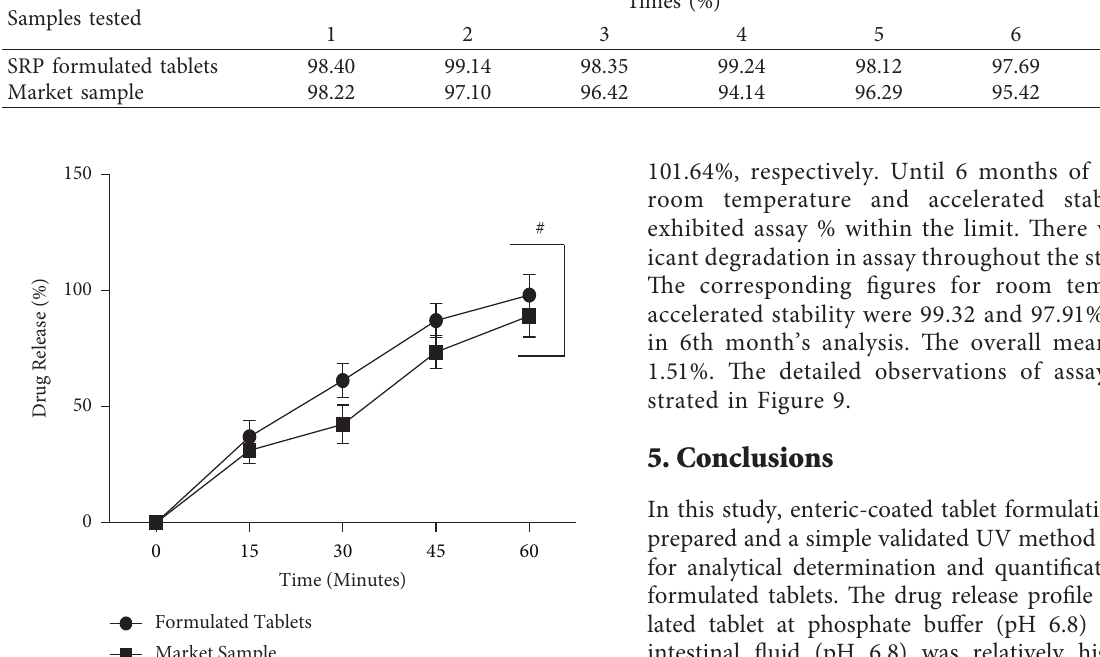
Figure 8: SRP release in simulated intestinal fluid (pH 6.8): # P > 0 . 05 compared to market